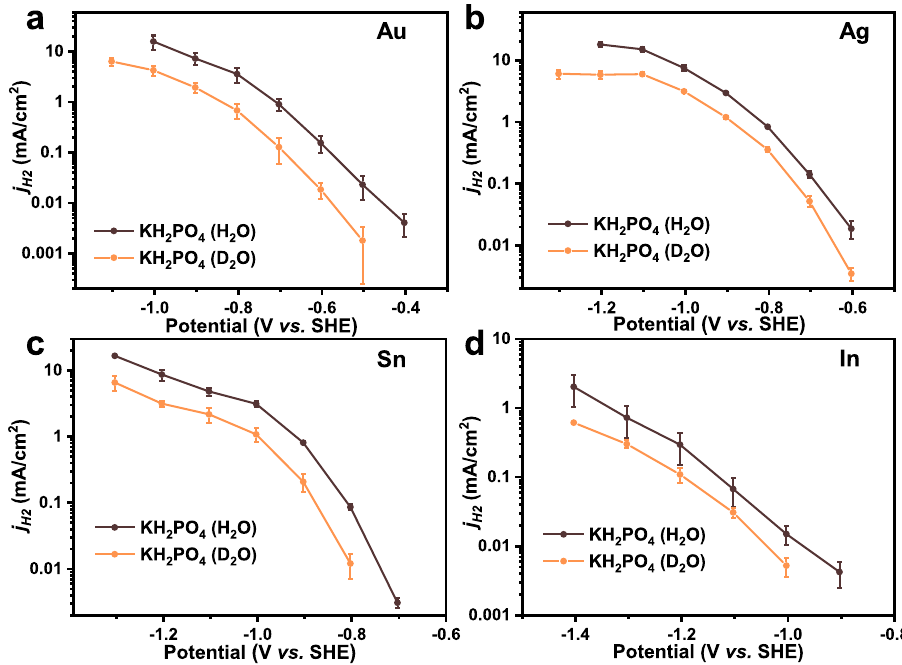
Fig. 4 Kinetic isotope effect for HER. The j H2 for Au ( a ), Ag ( b ), Sn ( c ) and In ( d ). The data were obtained from running CO 2 ER experiments at 0.1 M KH 2 PO 4 electrolyte with D 2 O and H 2 O. Error bars are means ± standard deviation ( n = 3